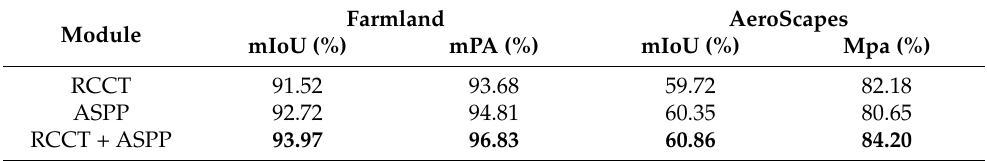
Table 3. Comparison of two encoder modules.